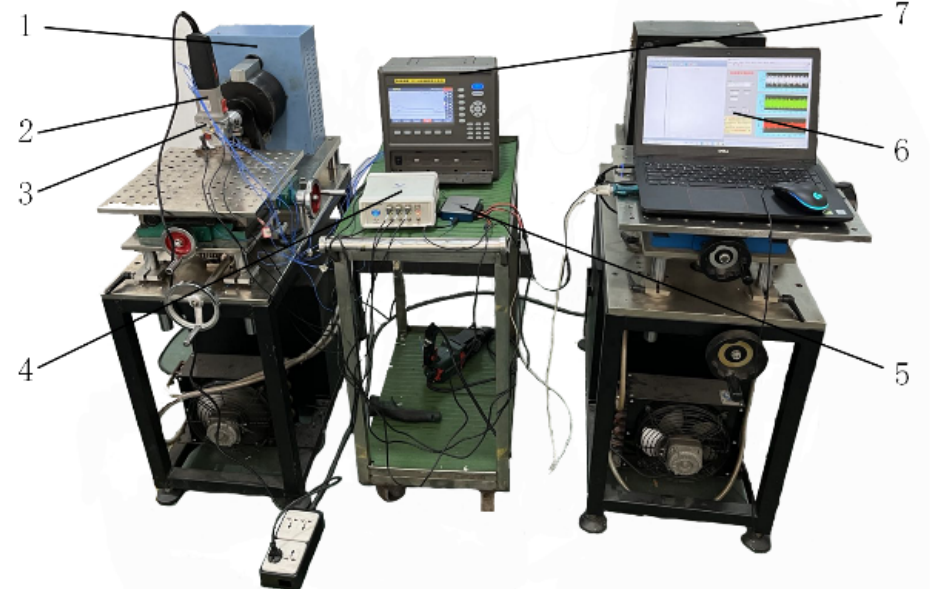
Figure 3. The data acquisition test bench. (1) Eddy current dynamometer; (2) angle grinder; (3) triaxial acceleration sensor; (4) constant current excitation power supply; (5) USB-6001; (6) upper computer; (7) TP700 data recorder.